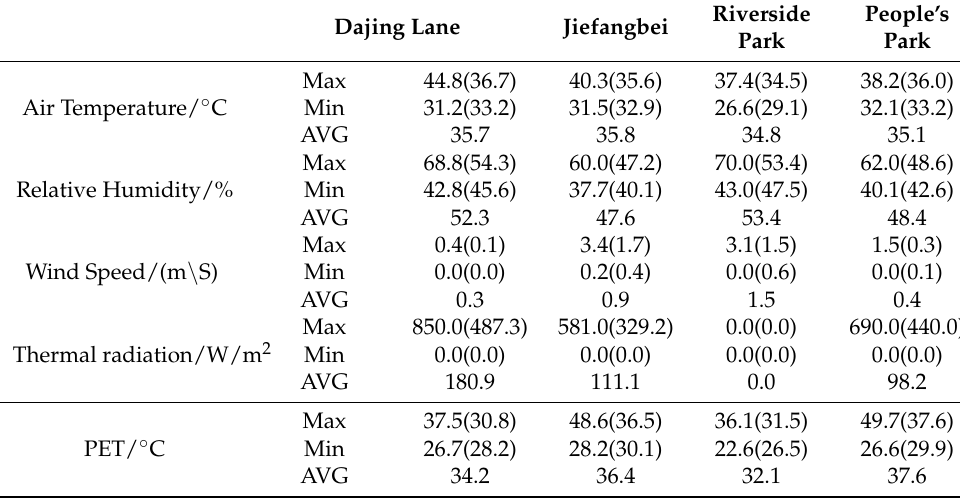
Table 2. Summary of the data used to calculate PET